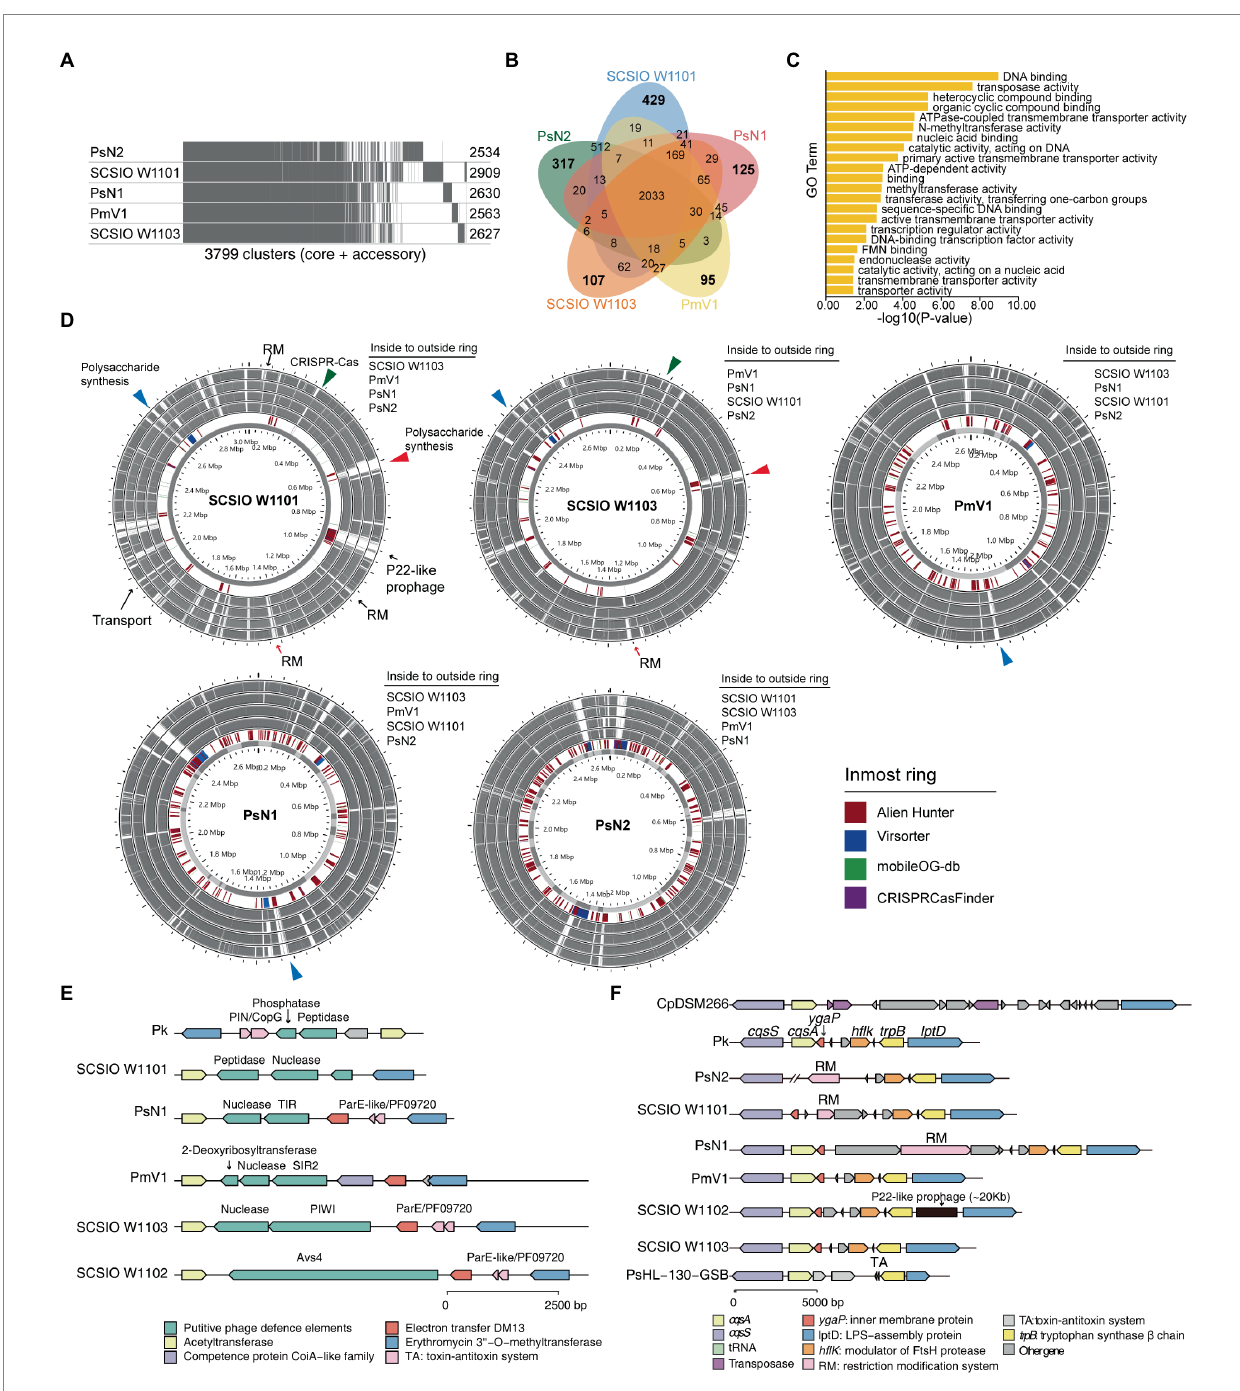
FIGURE 5 Polysaccharide synthesis gene cluster and phage defense systems drive the divergence and evolution within coral-associated Prosthecochloris (CAP) genomes. (A) Pangenome analysis of five CAP genomes. Considering the genome quality of MAGs, Candidatus Prosthecochloris korallensis and Candidatus Prosthecochloris sp. A305 and Candidatus Prosthecochloris sp. SCSIO W1102 were not included. Numbers at each line indicate the CDS numbers of each genome. A total of 3,799 gene clusters were found. (B) Venn diagrams of shared and specific genes among five CAP genomes. (C) Enrichment of Candidatus Prosthecochloris sp. SCSIO W1101 specific genes based on GO annotation of molecular functions (MF). (D) Genome alignment of these five genomes. Each genome was used as the reference, and MGE related regions predicted by different tools are indicated in the inmost ring. The same colored arrows or triangles indicate aligned variable genomic regions in different genomes. (E) Different phage defense systems are inserted in the conserved genomic regions in different genomes. (F) The absence of cqsA in the SCSIO W1101 genome may be caused by the integration or excision of